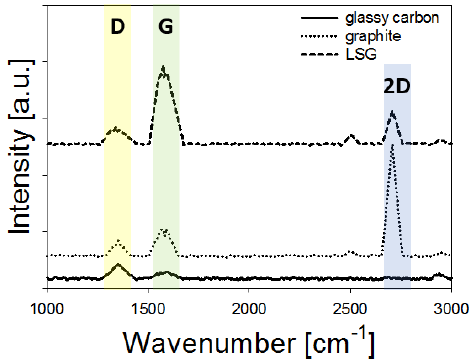
Figure 3. Raman spectra for glassy carbon electrode, graphite, and LSG. Characteristic peaks are apparent for D, G and 2D bands for the LSG, which is associated with graphene.